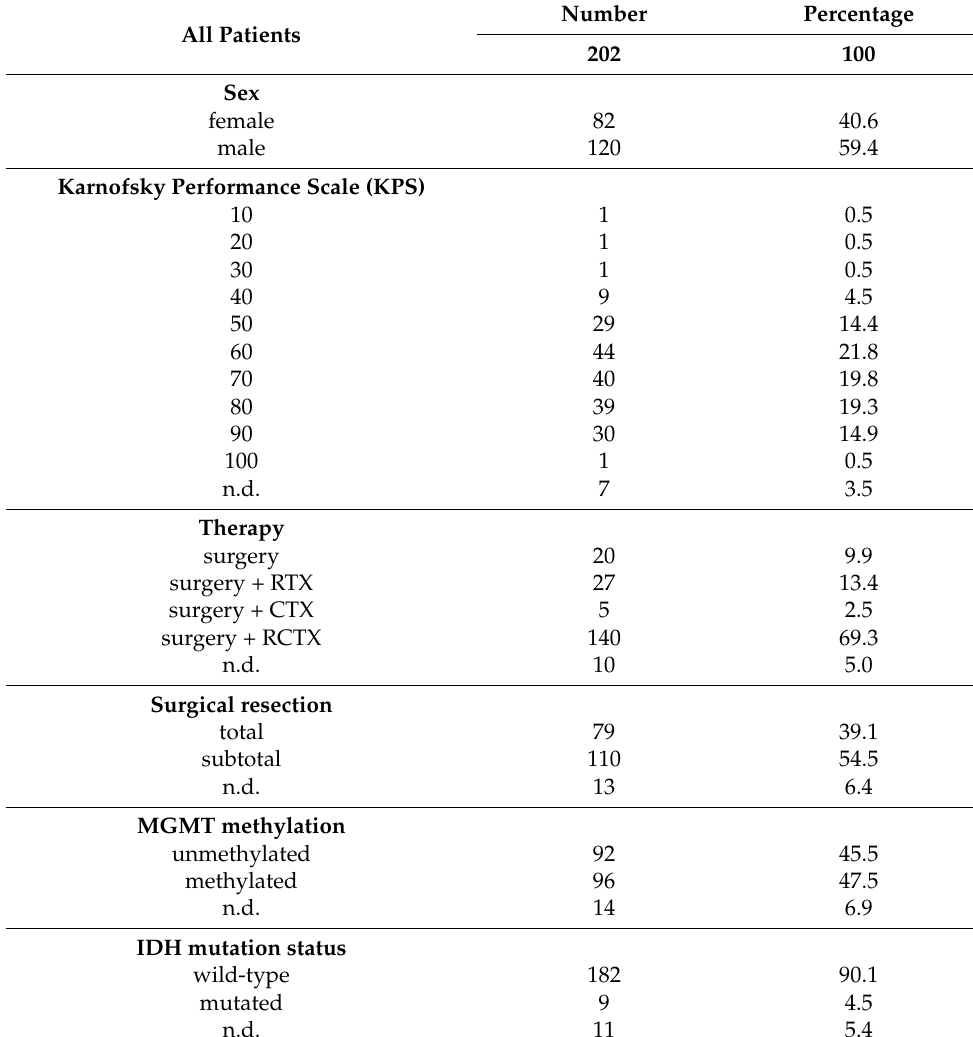
Table 1. Clinical characteristics of GBM patients. RTX: radiotherapy; CTX: chemotherapy; RCTX: radio-chemotherapy; n.d.: not